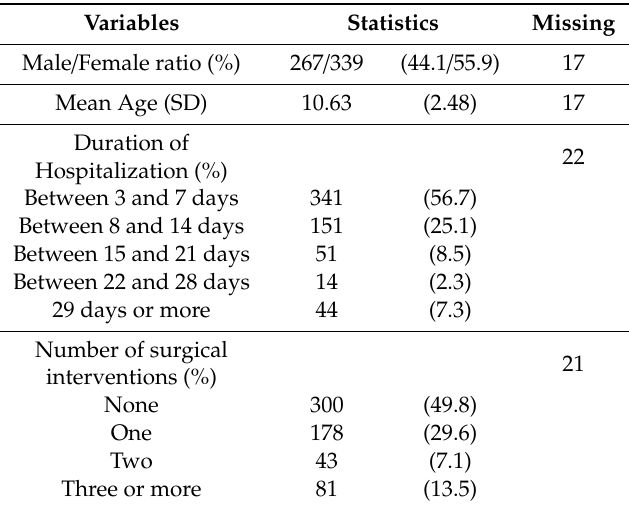
Table 1. Background data of the